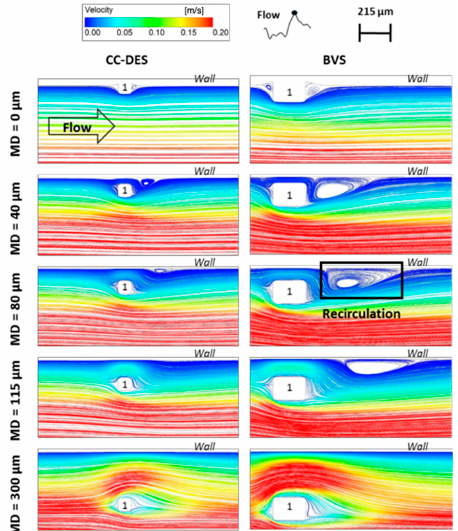
Figure 3. Most relevant streamlines in the vicinity of the first strut at the diastolic peak induced by Cobalt-Chromium drug-eluting stent (CC-DES) and bioresorbable stent (BVS) stent for MD = 0, 40, 80, 115 and 300 µm.